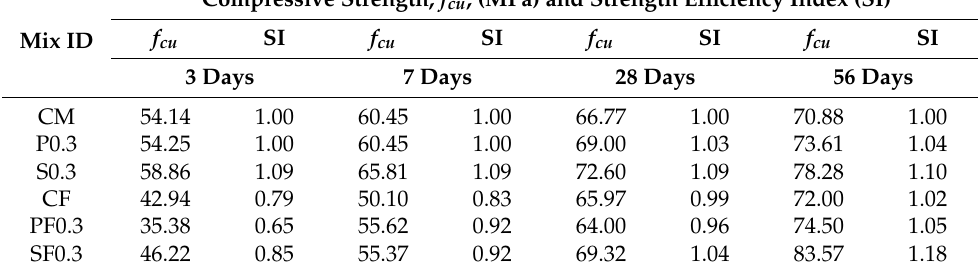
Table 3. Compressive Strength (Cube) of all Concrete